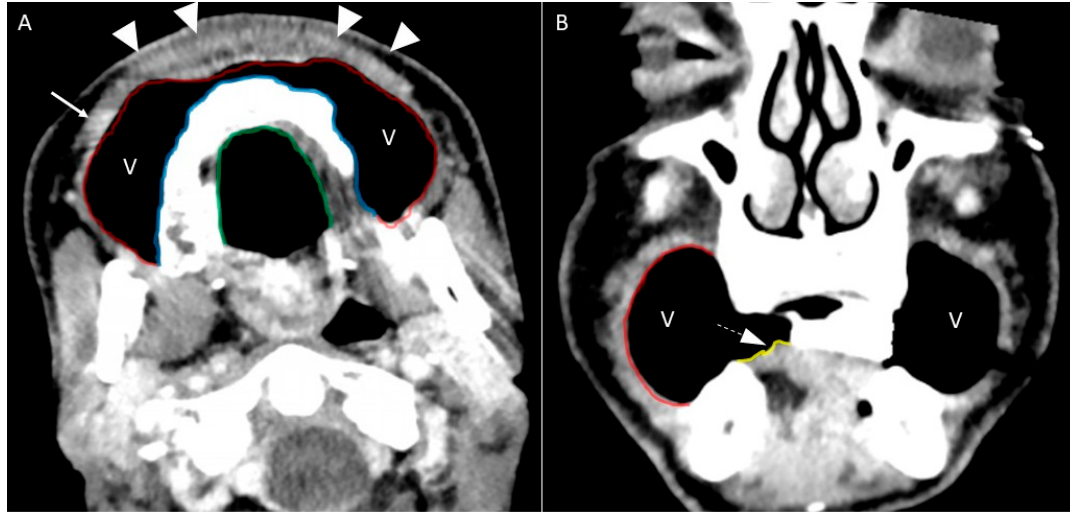
Figure 10. Puffed cheek technique. MSCT ( A ) Axial contrast-enhanced scan. ( B ) Coronal contrast- enhanced scan. This technique allows to stretch and visualise the oral vestibule (V), as well as to separate the buccal (red), maxillary gingival (blue), palatal (green), and lingual (yellow, dotted arrow in ( B )) mucosal surfaces. In this case, a subtle enhancing thickening in the buccal mucosa with infiltration of the buccinator muscle is highlighted (arrow in ( A )). With puffed cheek technique, facial muscles (risorius, levatorangulioris, depressor angulioris, and orbicularis oris) create a broad soft tissue density pseudomass (arrowheads in ( A )) that should not be confused with a real